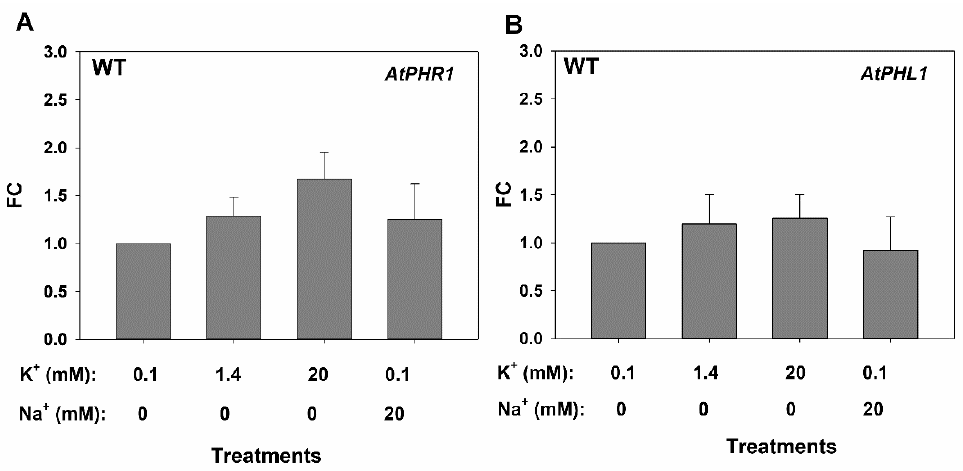
Figure 6. Effects of external K + and Na + on the expression of the AtPHR1 ( A ) and AtPHL1 ( B ) genes. Plants of WT were grown and processed as described in Figure 5. Then roots were harvested and their total RNA extracted to synthesize cDNA that was used for real time PCR determinations of gene expression by the ∆∆ Ct method. Shown are the averages of three repetitions for the Fold-Change of gene expression with respect to the calibrator sample corresponding to the 0.1 mM KCl treatment.